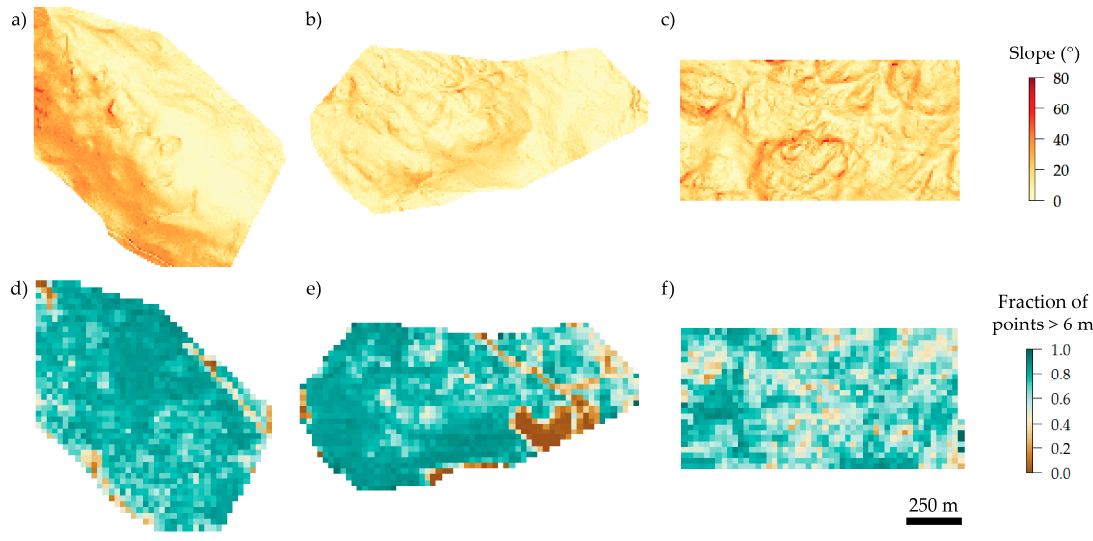
Figure 4. Spatial distribution of the 1 m × 1 m resolution ALS derived slope layer for areas A, B and C respectively ( a – c ), and canopy cover ( d – f ) defined at 25 m × 25 m cell resolution.